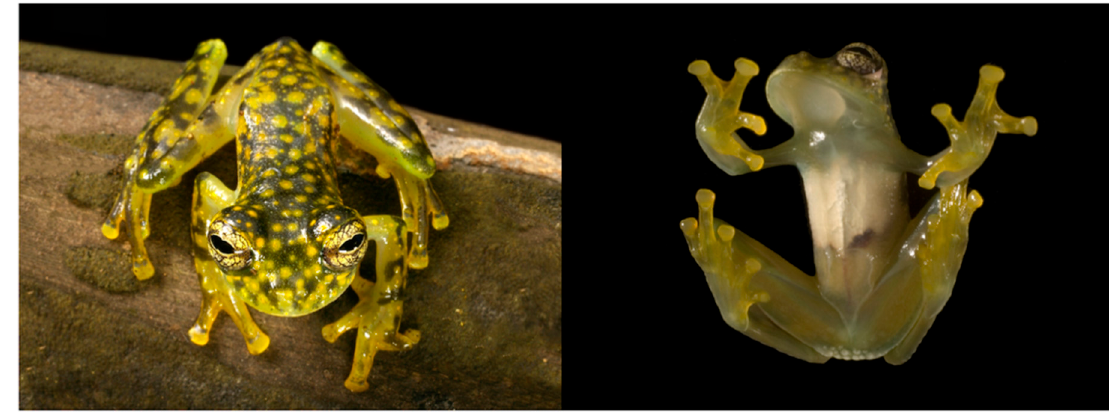
Figure 198. Sachatamia albomaculata in life, adult male, QCAZ 40816. Ecuador: Imbabura: near Lita, ca. 500 m. Photos by M. Bustamante ( left ) and Luis A. Coloma ( right ). Diagnosis: (1) Teeth on dentigerous process of the vomer present, each process bearing four to six teeth; (2) snout round to truncated in dorsal profile, and mostly truncated in lateral profile (Figure 199); (3) tympanum evident, its diameter 25.7%–34.2% of eye diameter, dorsal border of tympanic annulus covered by supratympanic fold, tympanic membrane clearly di ff erentiated from surrounding skin; (4) dorsal skin of males and females shagreen, spicules present in males; (5) skin on venter areolate; pair of enlarged subcloacal warts, which are more evident in females; (6) anterior half of ventral parietal peritoneum covered by white iridophores, posterior half transparent (condition P2); white pericardium; translucent peritoneum covering intestines, stomach, testes, kidneys, gall bladder, and urinary bladder (condition V1); (7) liver tetralobed, two large ventral lobes covering two smaller lobes; hepatic peritoneum transparent (condition H0); (8) humeral spines absent; (9) no webbing between Fingers I and II; webbing between other fingers as follows: II (1 1/3 –2 + )